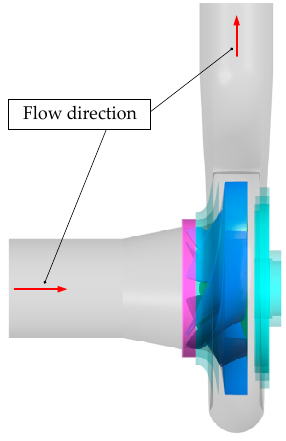
4 Figure 3. Installed positions of the hydrophones. (1) Pump outlet pressure transmitter 1; (2) pump inlet pressure transmitter 1; (3) pump outlet pressure transmitter 2; (4) accelerometer 3, Z direction; (5) accelerometer 1, X direction; (6) accelerometer 2, Y direction; (7) accelerometer 4, on the base; (8) pump inlet pressure transmitter 2.